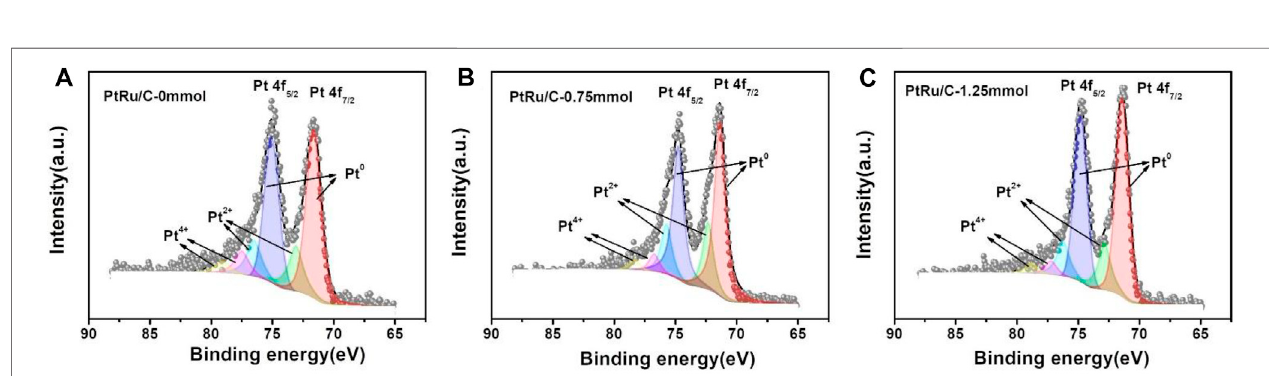
FIGURE 5 | XPS spectra of Pt 4f of (A) PtRu/C-0 and (B) PtRu/C-0.75 (C) PtRu/C-1.25 samples.